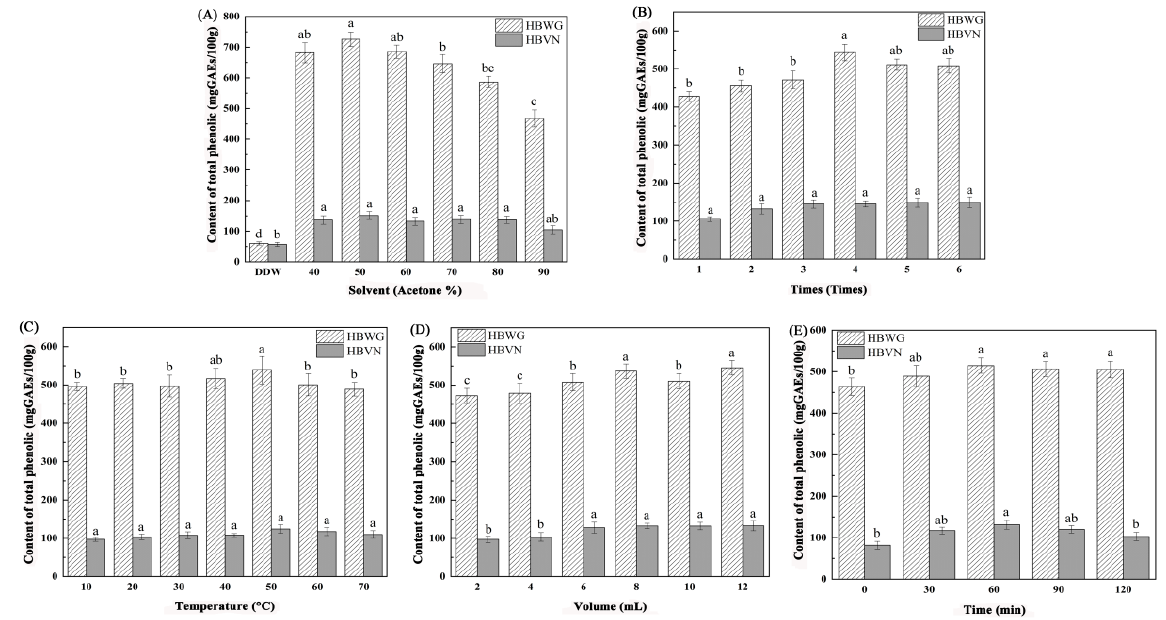
Figure 1. Extraction conditions of HBWG using the total phenolic compounds as the evaluation criterion. ( A ) Solvent, ( B ) Times, ( C ) Temperature, ( D ) Volume, and ( E ) Time. Error bars are standard deviations ( n = 3). Different letters above the columns represent significant difference at p < 0.05.